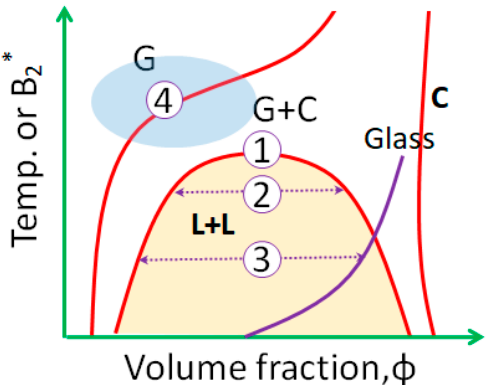
Figure 1. Schematic concepts of nonclassical pathways of crystallization for a system exhibiting a metastable liquid–liquid phase transition (LLPS) in the phase diagram. Here, G, L, and C are the gas, liquid, and crystal phases; B 2 * is reduced second virial coefficient. The gas (G) and liquid (L) phases correspond to a low and high concentration of particles in solution.